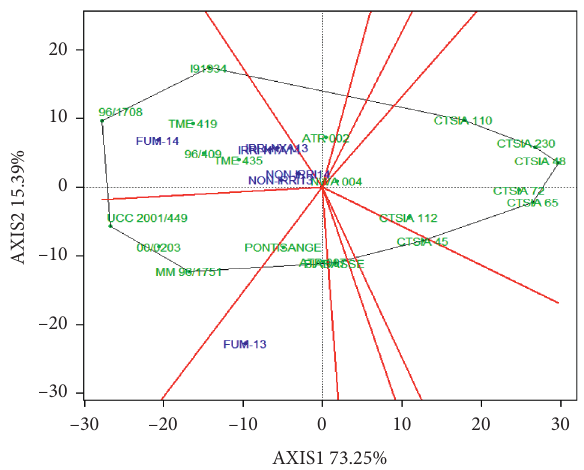
Figure 6: GGE biplot showing best genotypes for fresh root yield (t/ha) of 20 cassava genotypes in six environments. FUM- 13 � Fumesua 2013, NON-IRRI13 � no irrigation 2013, IRRI- NYA13 � irrigation 2013, FUM-14 � Fumesua 2014, NON- IRRI14 � no irrigation 2014, and IRRI-NYA14 � irrigation